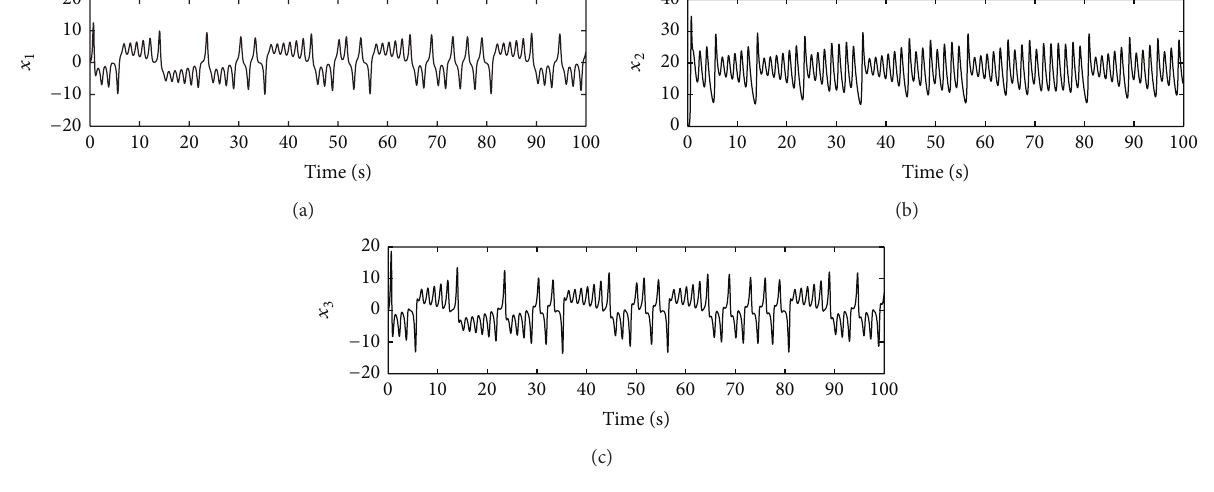
Figure 5: Chaotic oscillations of an uncontrolled